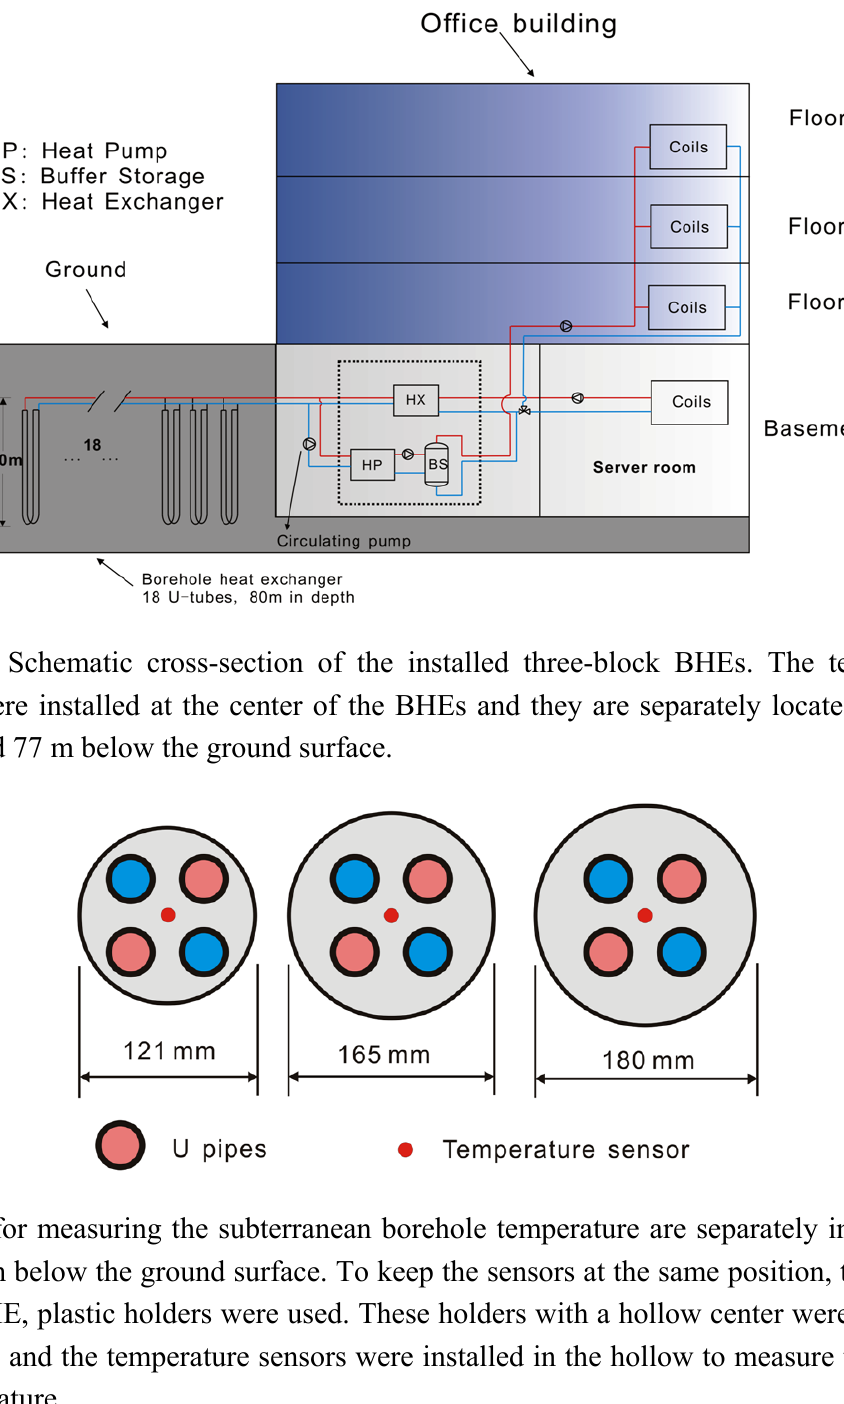
Figure 3. Schematic diagram of the GSHP system with vertical double U-tube BHEs. The BHEs of this GSHP system are in parallel connection.